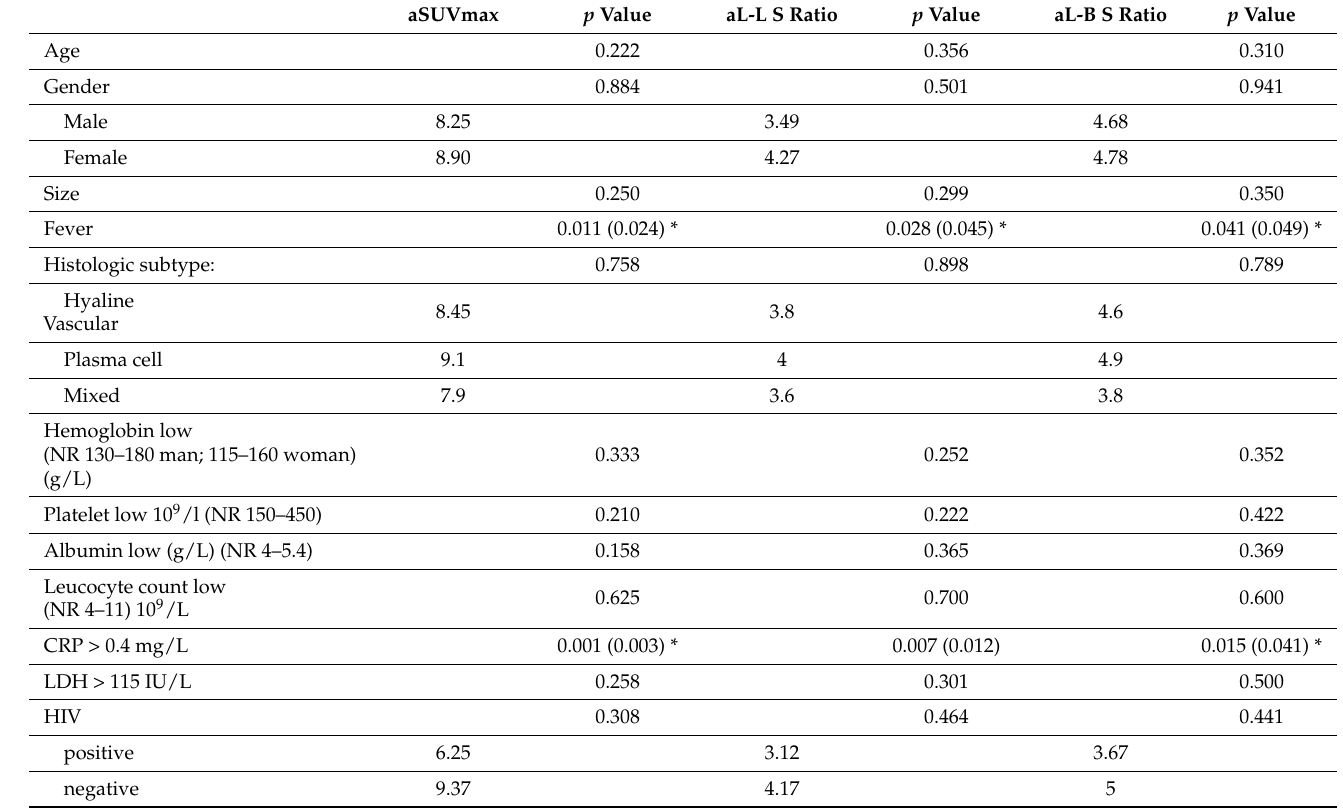
Table 2. Comparison between SUVmax, lesion-to-liver SUVmax ratio, lesion-to-blood pool SUVmax ratio, and the main clinical-pathological